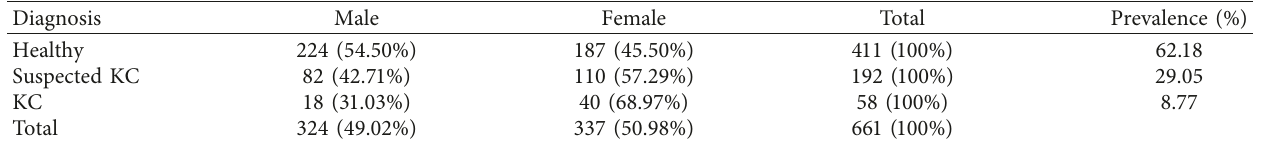
Table 2: Comparison of sexes in the healthy, suspected KC, and KC groups.